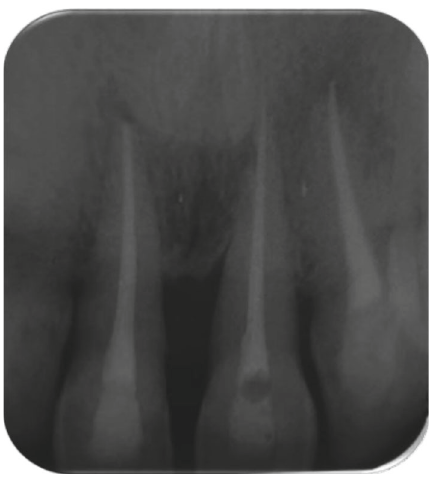
Figure 8: 18-month follow-up of teeth.